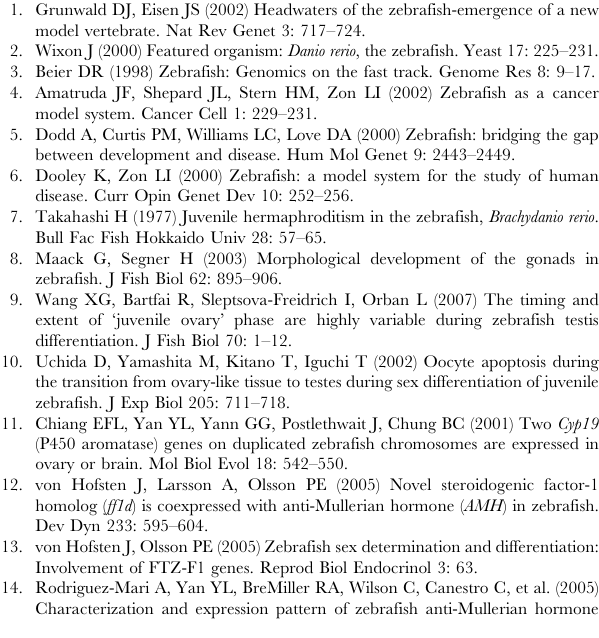
Table S11 Complete list of probes on Gonad